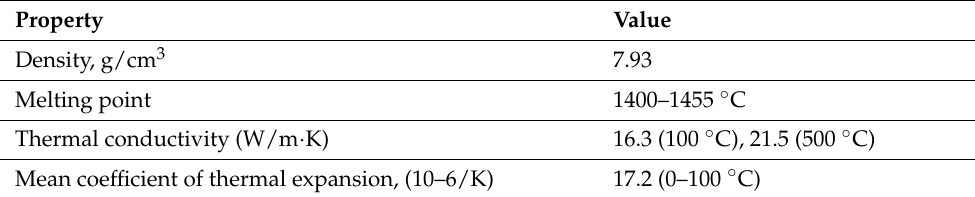
Table A3. Physical Properties of Stainless